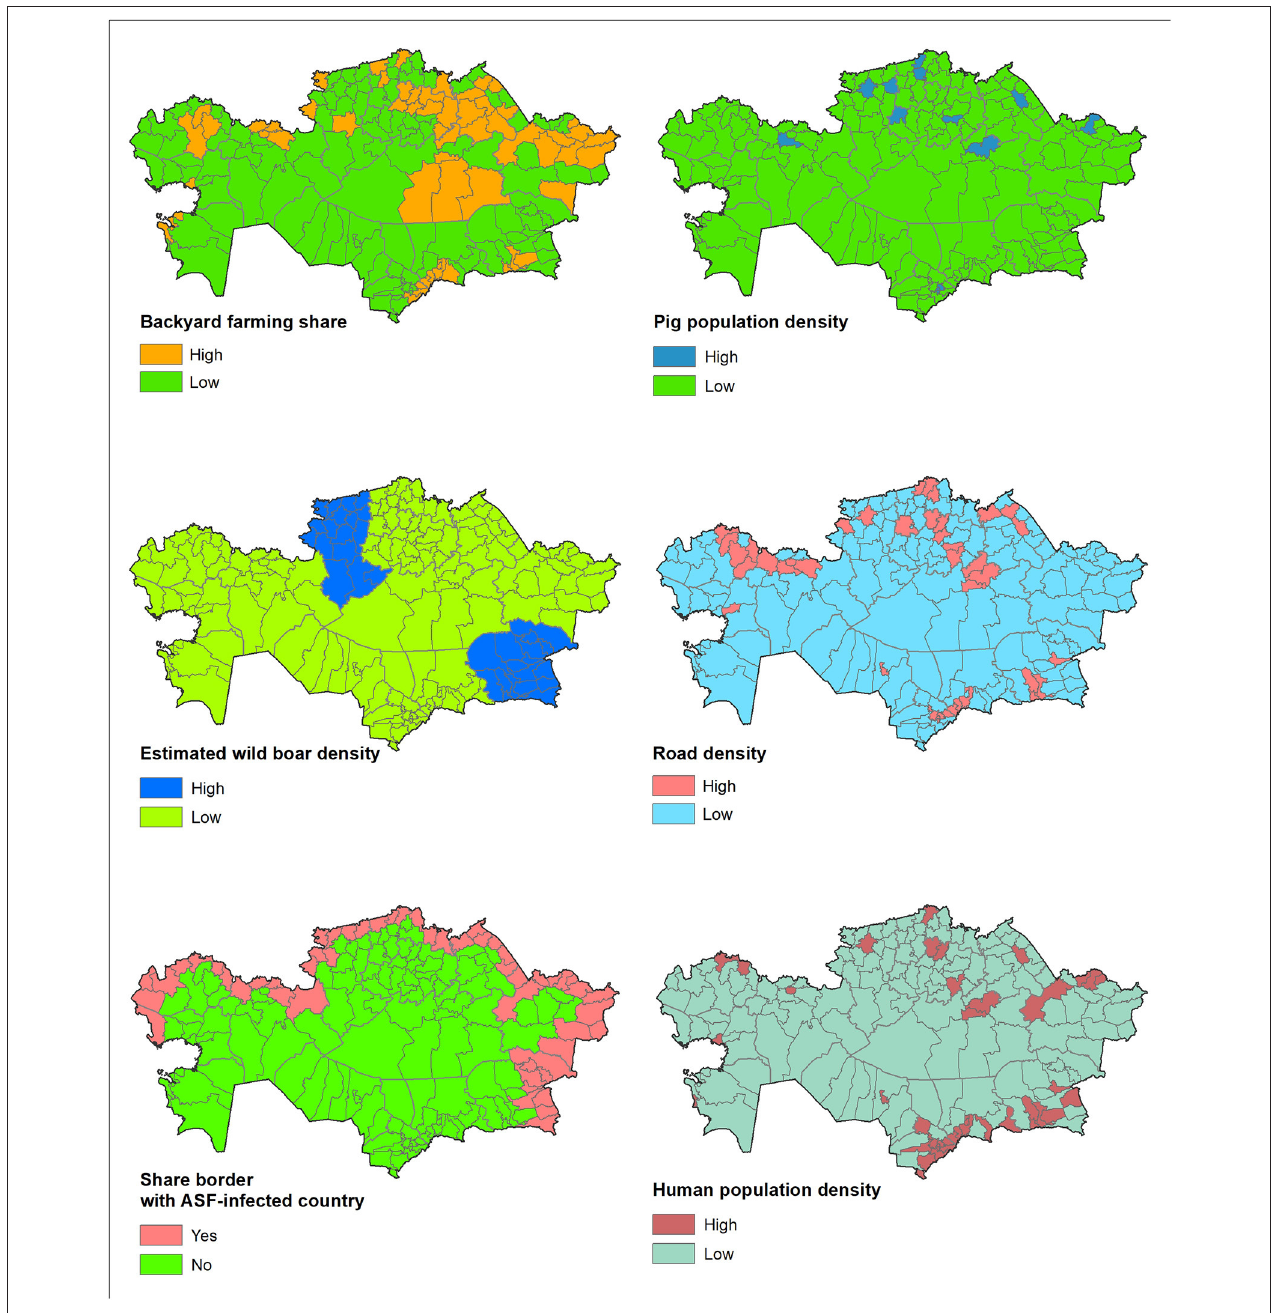
FIGURE 1 | Kazakhstan district-level data for the variables used in the model (backyard farming share, domestic pig density, estimated wild boar density, share-border with ASF-infected country, human population density, and road